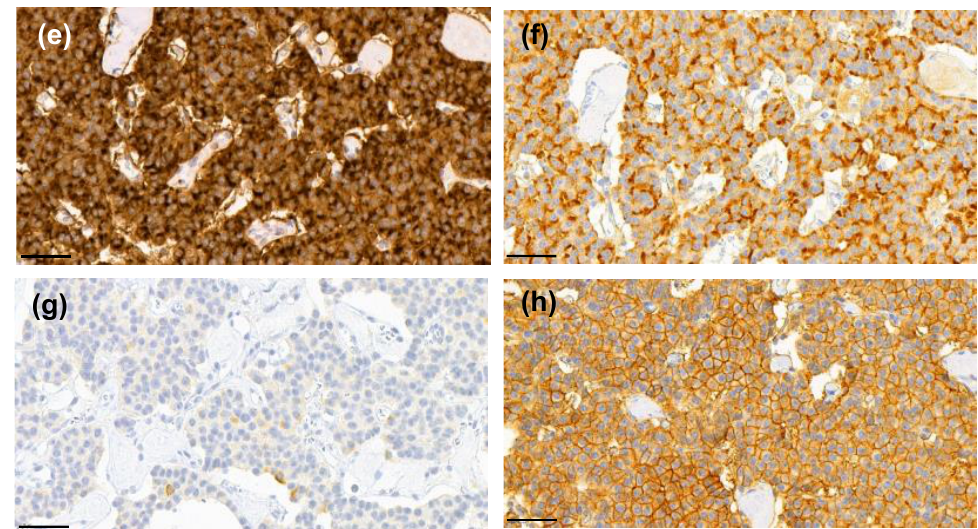
Figure 7. A 25-year-old female patient who had MEN1 syndrome had a 10-cm mass in the tail of the